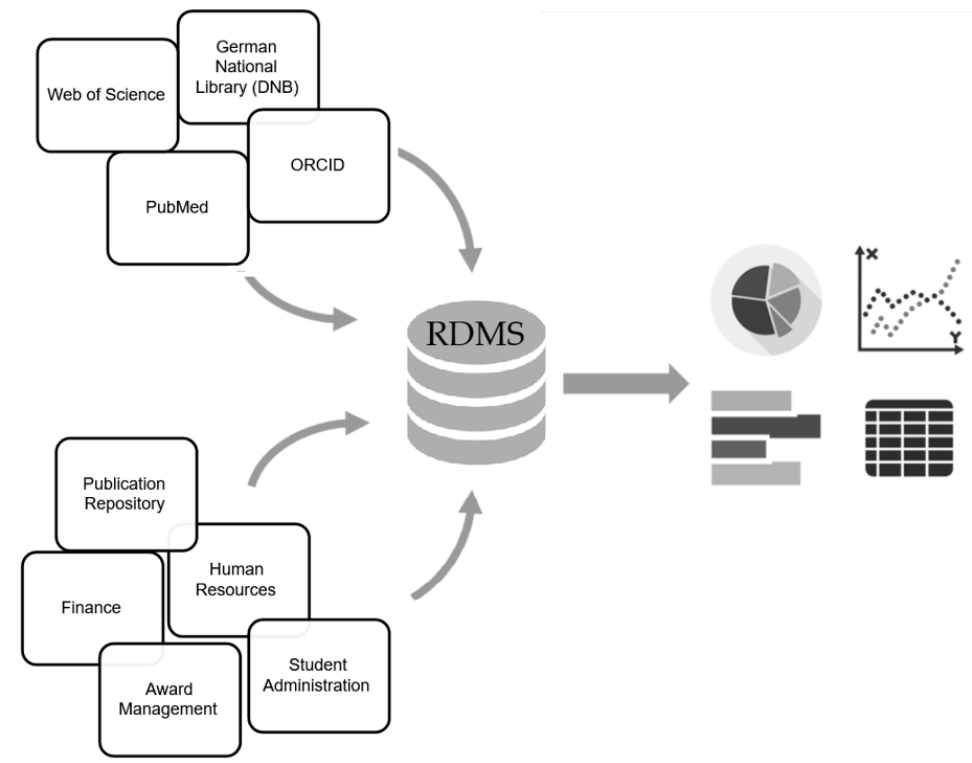
Figure 1. Example of an research data management systems (RDMS) in research institutions.